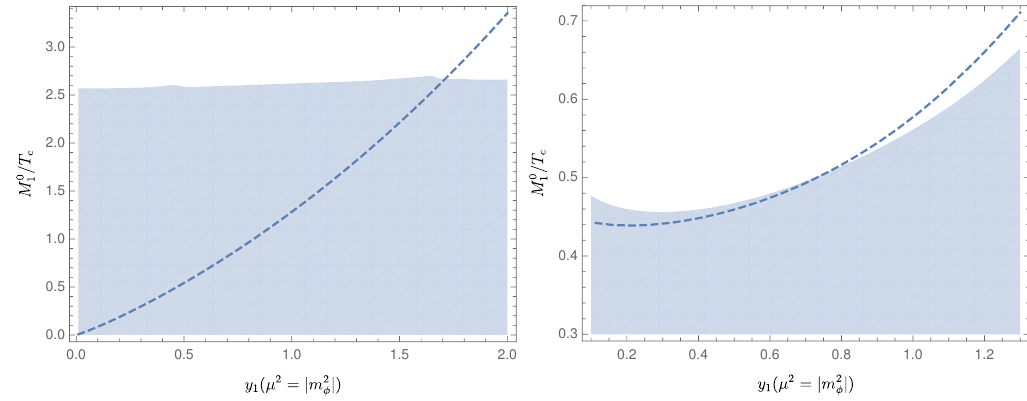
Figure 7 . Allowed regions for M 0 =T c in single-scalar models with degenerate N I and a constant I zero-temperature VEV h (cid:8) i . The shaded regions show allowed parameters with the RG-improved full one-loop e(cid:11)ective potential (including thermal Daisy resummation [63]), while the dashed lines show the relationship between M 0 =T c and y I obtained with the e(cid:11)ective potential ignoring zero- I temperature loop corrections and keeping only terms in the high- T expansion. Left pane: upper bounds found by demanding the existence of a local metastable minimum at (cid:12)eld values (cid:24) m (cid:8) , and zero-temperature VEV h (cid:8) i (cid:24) 6 (cid:2) 10 9 GeV. Right pane: upper bounds obtained by demanding stability of the scalar potential up to the Planck scale, and zero-temperature VEV h (cid:8) i (cid:24) 0 : 7 (cid:2) 10 9